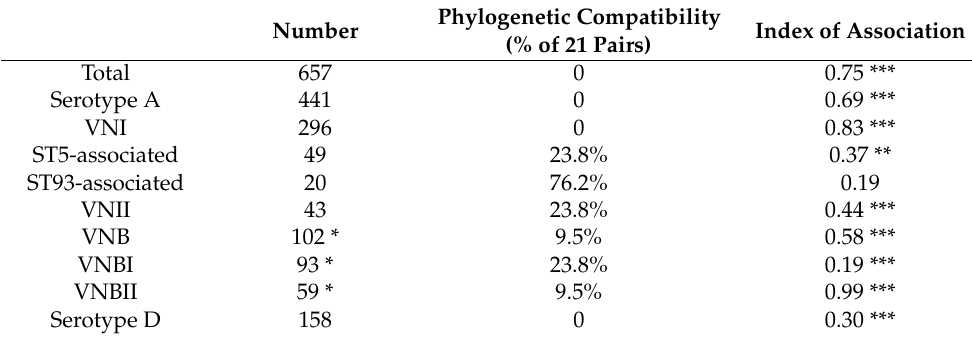
Table 8. Summary of genotypic diversity and phylogenetic incompatibility based on the sequence type and molecular type information assigned by the MLST database. ** p < 0.01; *** p < 0.001.